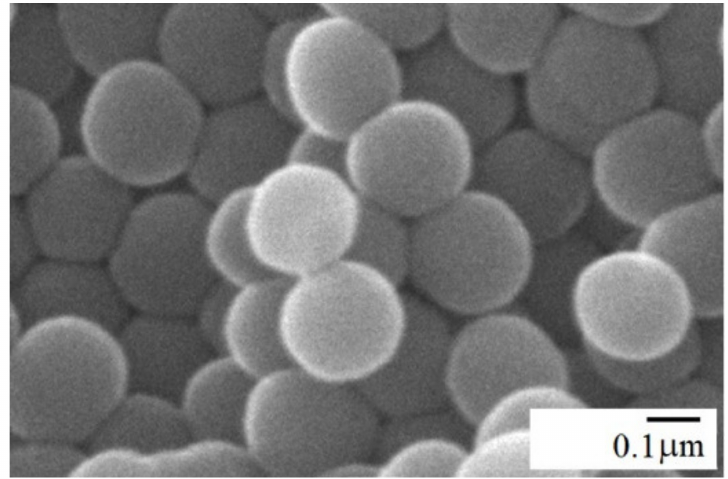
Figure 2. SEM micrograph of A-SiO 2 particles with an average size of 30